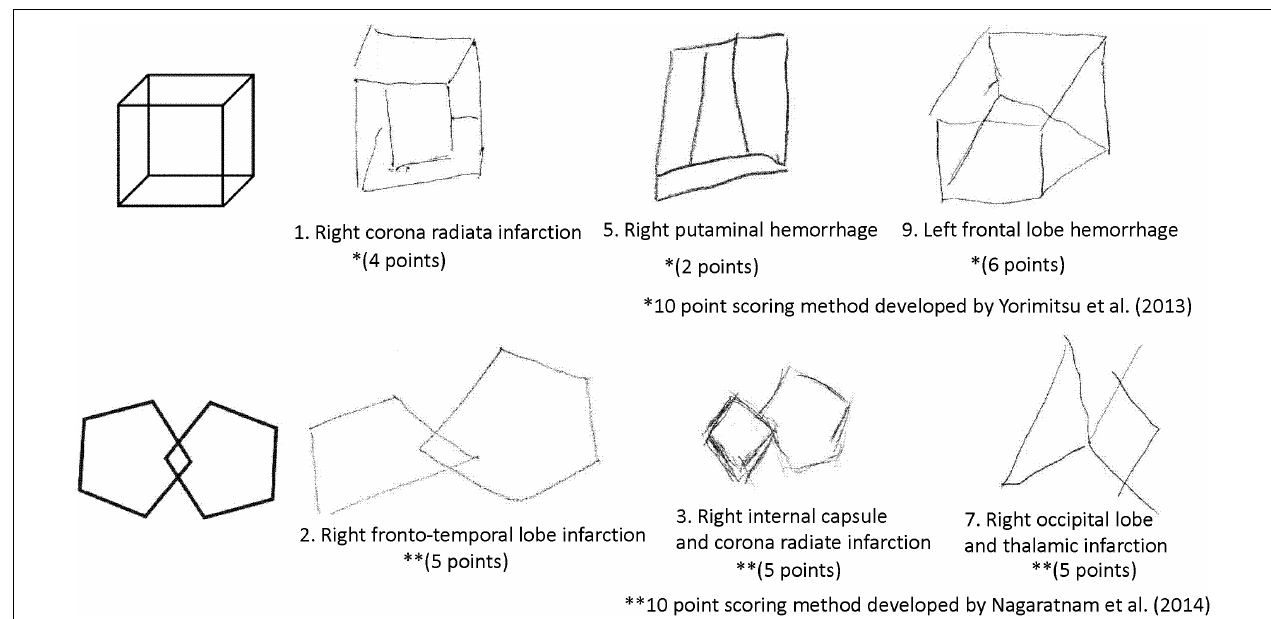
FIGURE 1 | Sample drawings of a cube and an intersecting pentagon from the constructional apraxia group.